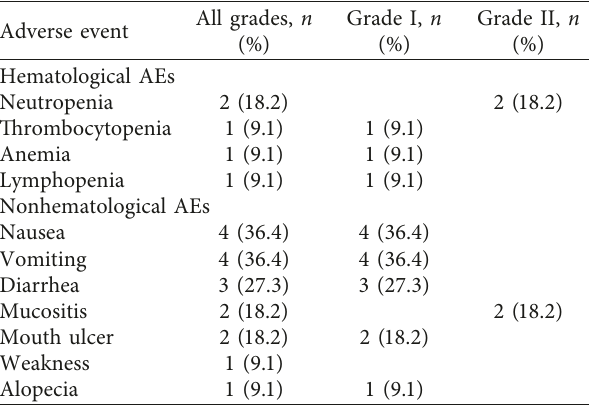
Table 3: Safety profile of NDLS based chemotherapy in sarcoma ( n �